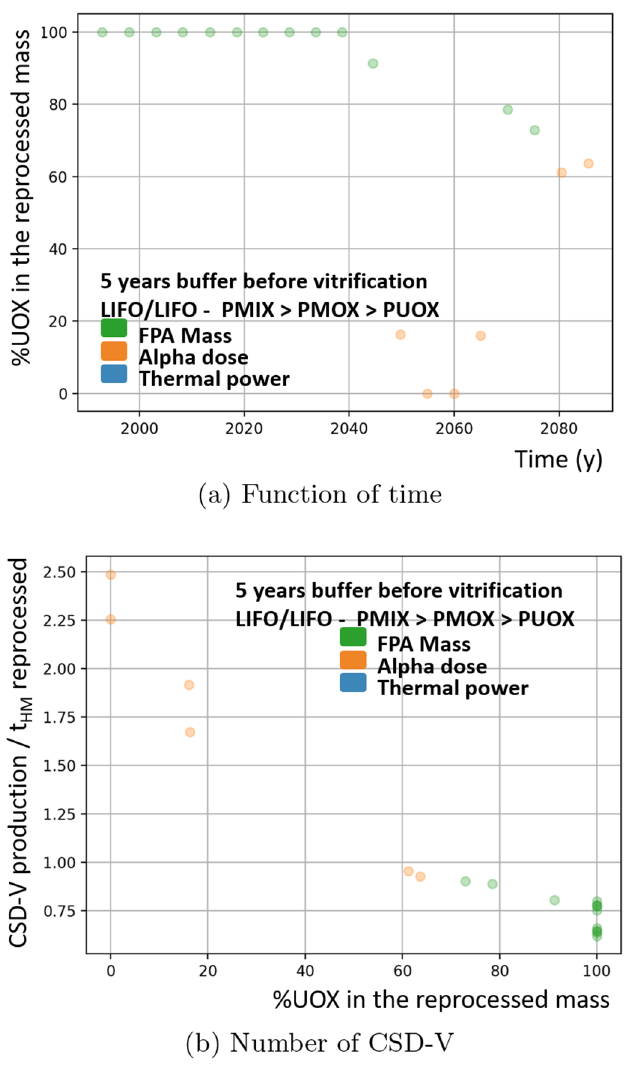
Fig. 13. Limit reached with a 5-year buffer before vitrification according to the percentage of UOX fuel in the canister.